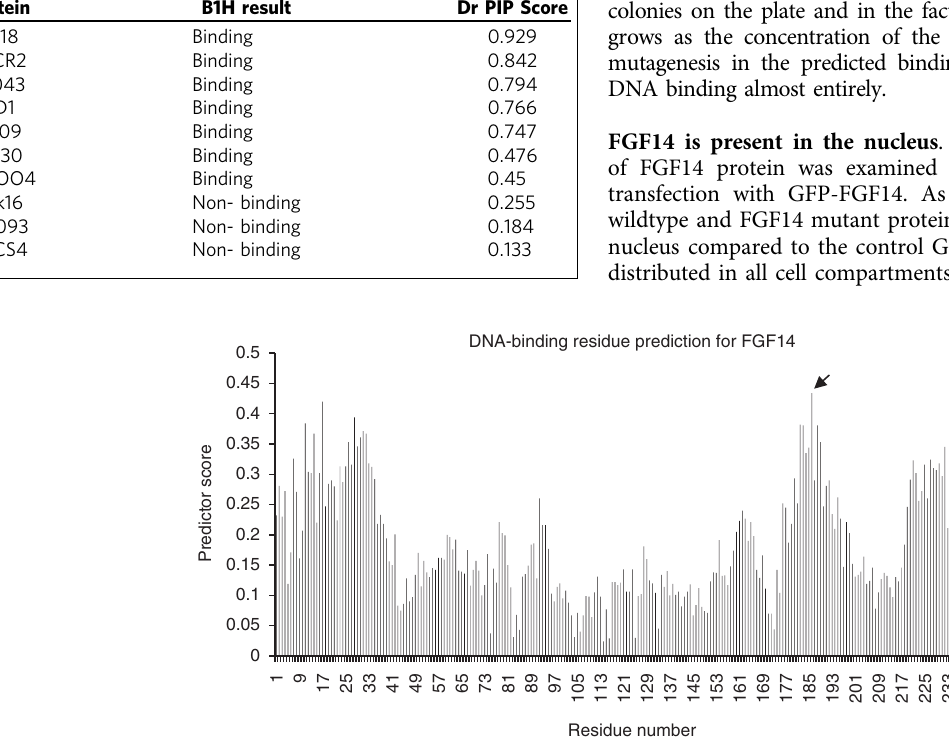
Figure 3 | Score per residue from the DNA binding residue prediction for FGF14. Arrow marks the residue that got the highest score. NATURE COMMUNICATIONS|7:13424|DOI: